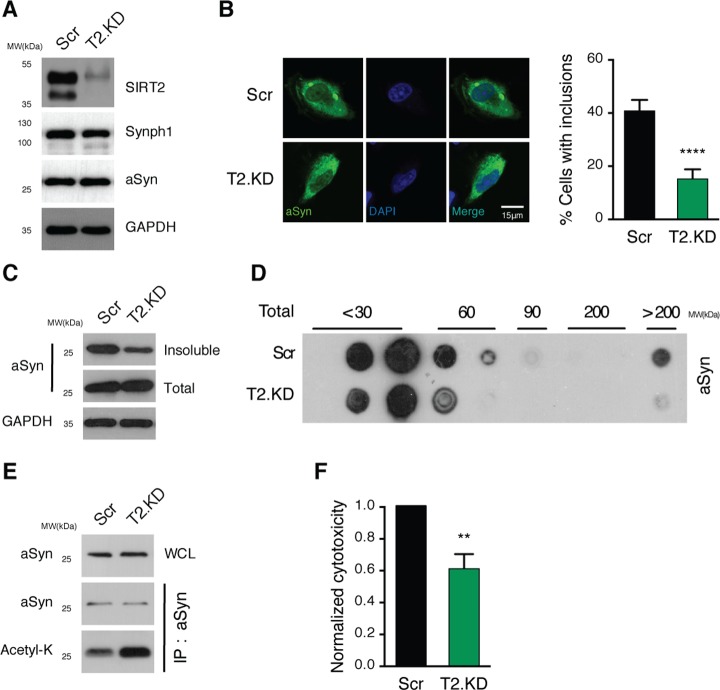
SIRT2 regulates aSyn aggregation and toxicity.(A) H4 cells were infected with lentiviruses encoding shRNAs against SIRT2 (T2.KD) or scramble shRNA (Ctrl) and selected with puromycin. Cells were then cotransfected with SynT and synphilin-1 (Synph1). SIRT2, synphilin-1, aSyn, and GAPDH levels were assessed by immunoblot analyses. (B) Ctrl and T2.KD cells transiently expressing SynT and synphilin-1 for 48 h were processed for immunocytochemistry (ICC) (aSyn, green). Data show percentage of cells with aSyn inclusions (n = 3). Scale bar 15 μm. (C) Triton X-100 insoluble and total fractions of cells as in (B) probed for aSyn and GAPDH. (D) Native protein extracts from H4 cells as in (B) were separated on a sucrose gradient. Fractions were immunoblotted and probed for aSyn. (E) Anti-aSyn IP from cells as in (B). Fractions were immunoblotted and probed for acetyl-lysine and aSyn. (F) Toxicity of Ctrl and T2.KD measured by lactate dehydrogenase (LDH) release assay (n = 3). Data in all panels are average ± SD, ** p < 0.01, **** p < 0.0001. For (B) and (F), unpaired, two-tailed t test with equal SD. Data in S1 Data.